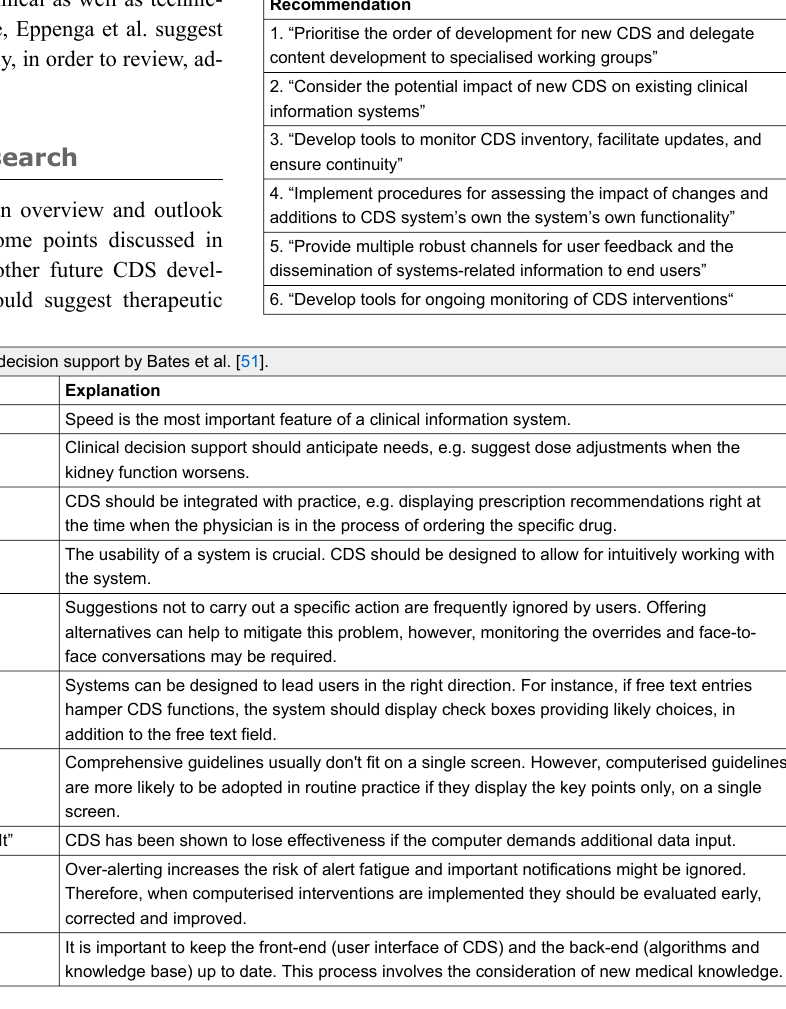
Table 3: Governance recommendations for CDS, according to Wright et al. [56].